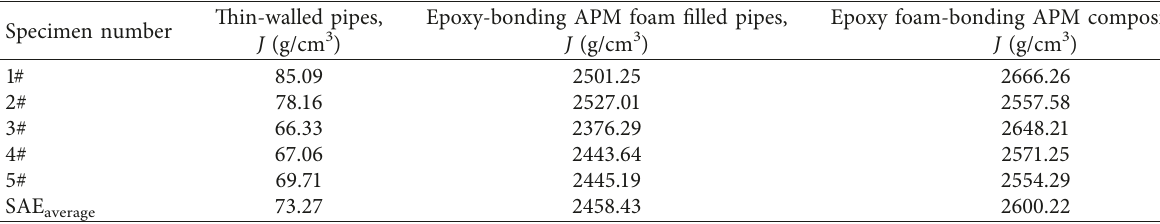
Table 4: Specific energy absorption of each specimen.